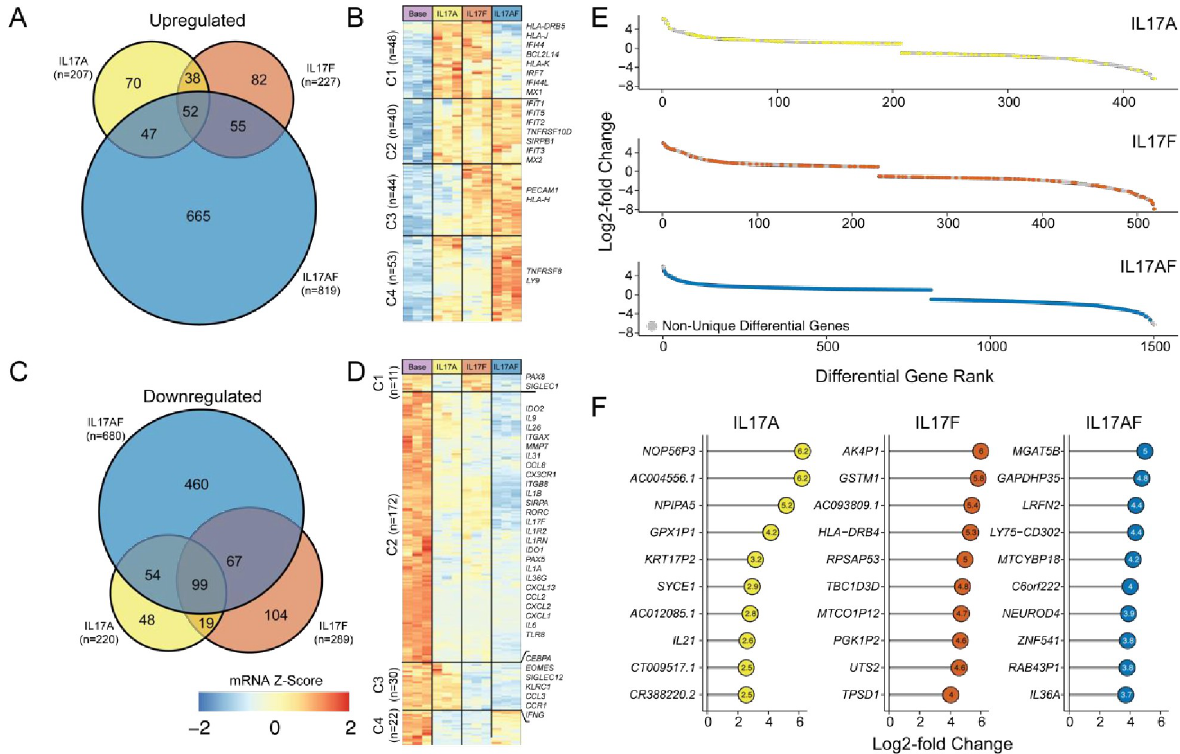
Fig 4. Overlapping and unique expression patterns in IL-17-treated conditions. Overlapping and unique upregulated genes in bulk CD4 + CD25 - T-cells in IL-17A, IL-17F, and IL-17AF conditions compared to media-only cells. B . Heatmap of upregulated genes in at least two of three conditions; clustering based on Euclidean distance with immune-related genes labeled. C . Overlapping and unique downregulated genes in bulk CD4 + CD25 - T-cells in IL-17A, IL-17F, and IL-17AF conditions compared to media-only cells. D . Heatmap of downregulated genes in at least two of three conditions; clustering based on Euclidean distance with immune-related genes labeled. E . Dispersion of differentially-regulated genes by condition, grey genes are common between at least two conditions and colored genes are unique to the indicated condition. F . Top 10 unique upregulated genes in each condition ordered by log2-fold